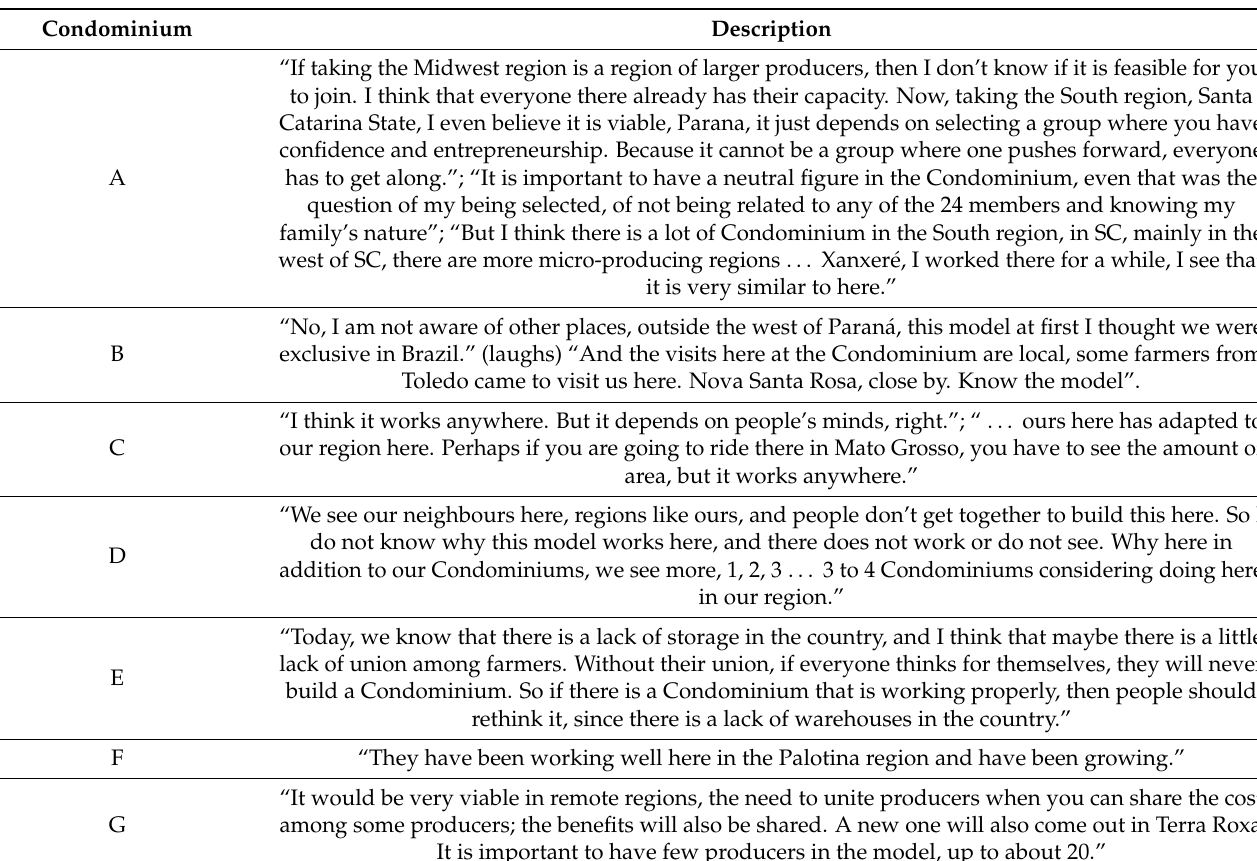
Table 7. Interviewees’ statements about the perspectives of the rural collective model Rural Ware- house Condominium in